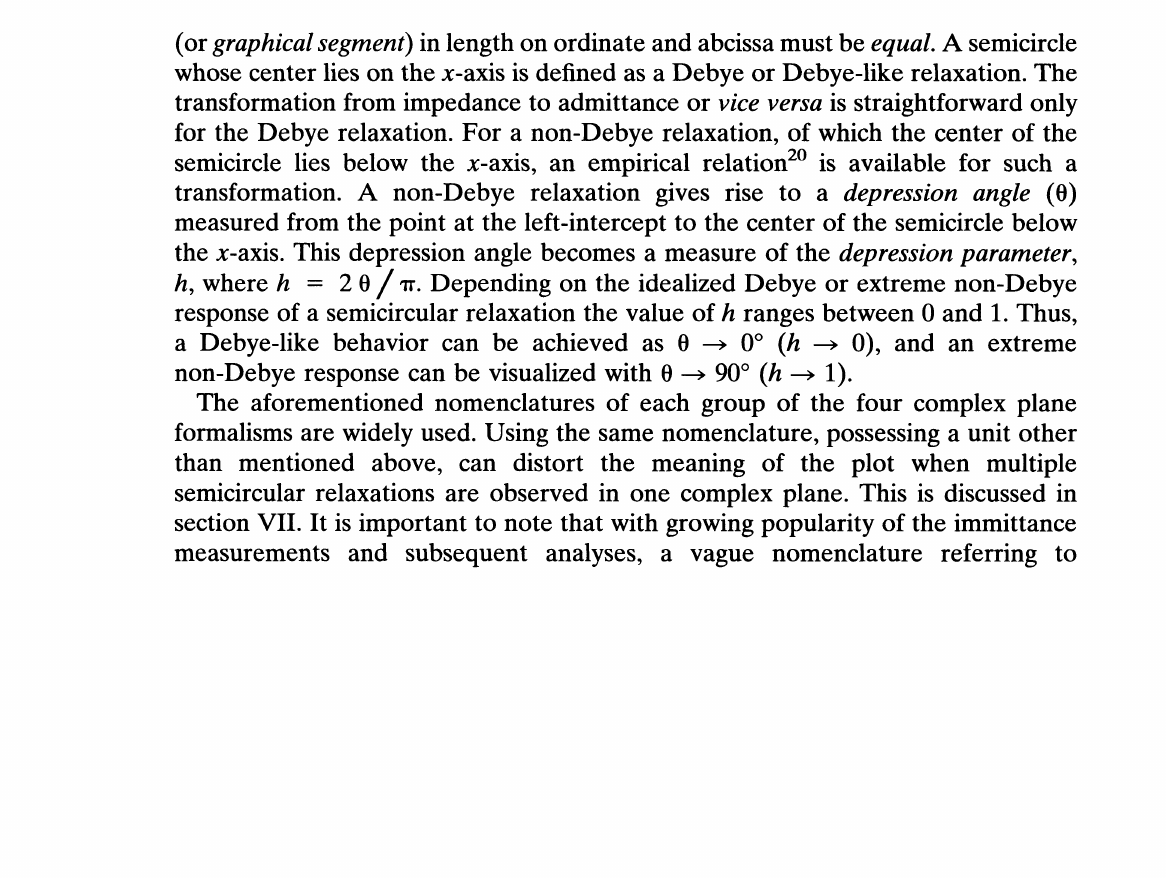
FIGURE 3 Sample plots with associated simplified equivalent circuits for each of the four complex